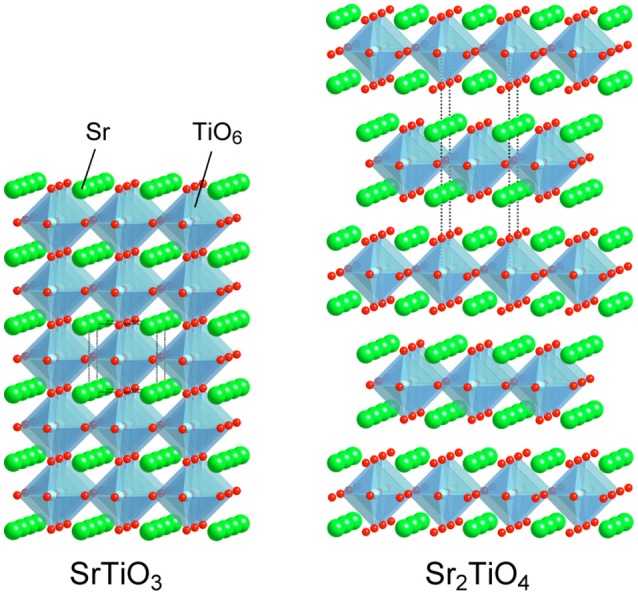
Crystal structures of SrTiO3 and Sr2TiO4.